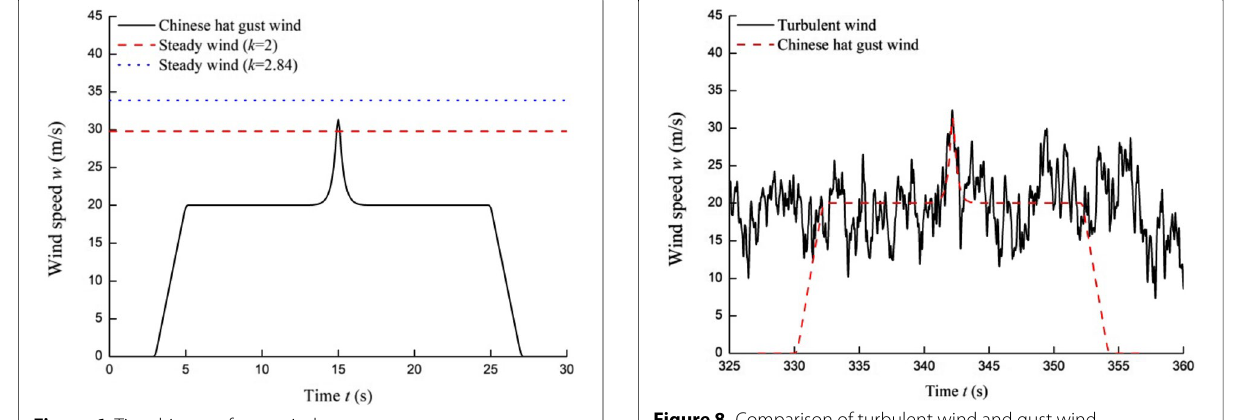
Figure 6 Time history of gust wind